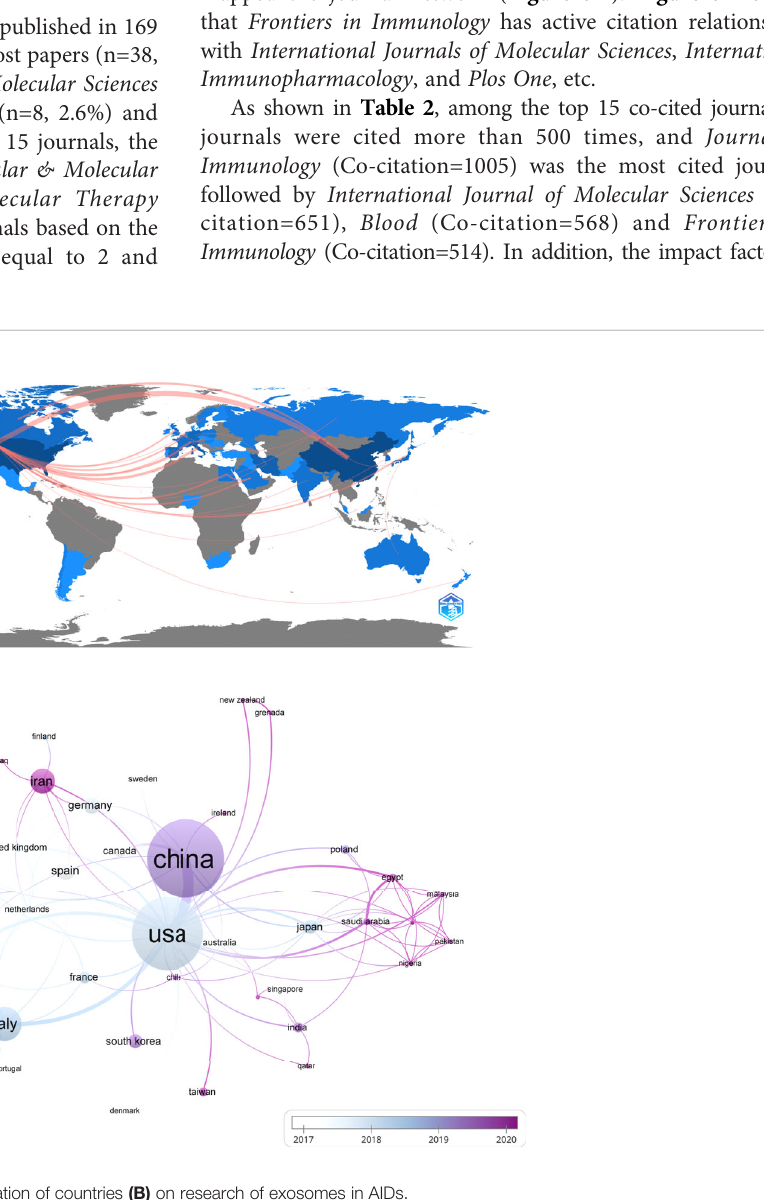
FIGURE 3 | The geographical distribution (A) and visualization of countries (B) on research of exosomes in AIDs.